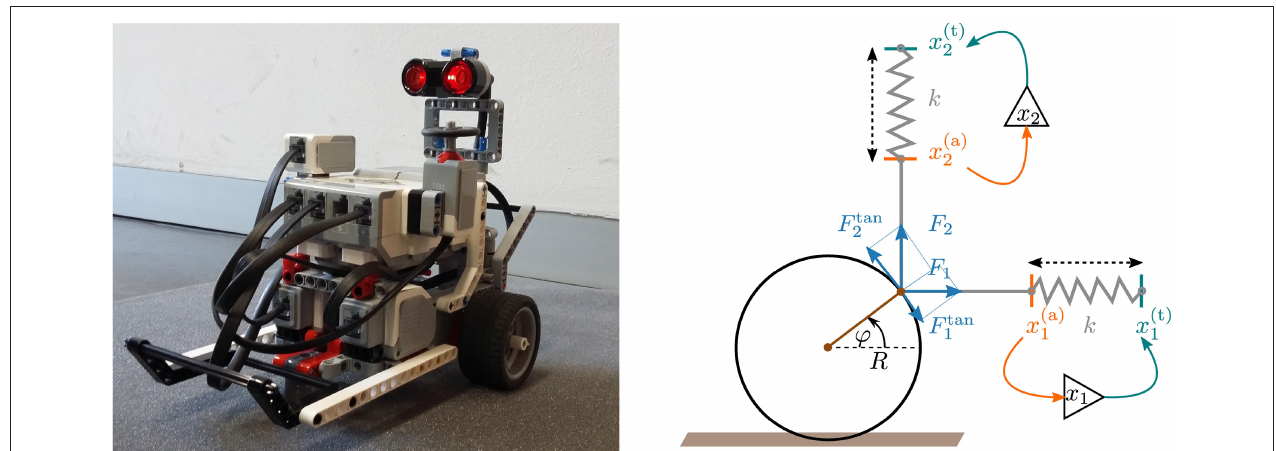
Frontiers in Neurorobotics |